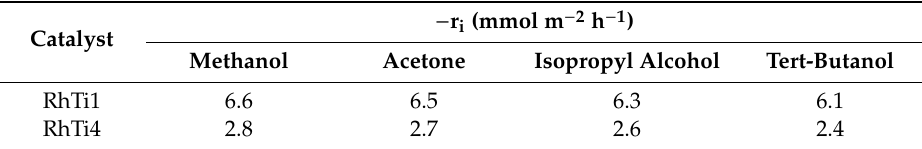
Table 4. Catalytic activity based on